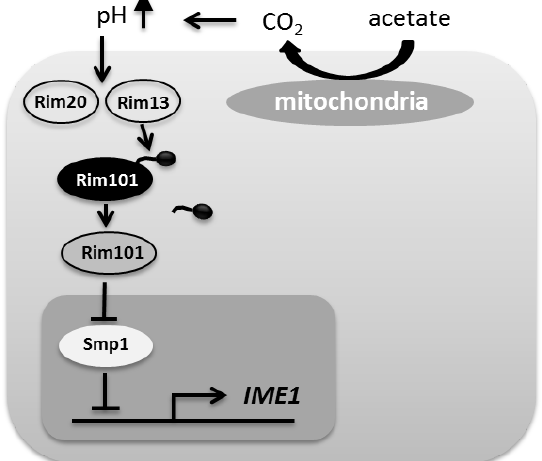
Figure 1. Induction of sporulation in response to alkaline pH in S. cerevisiae . When a non-fermentable carbon source is metabolized by respiration the external pH increases. The alkaline pH induces proteolytic activation of Rim101 by Rim13/Rim20. Rim101 then activates IME1 transcription by repressing transcription of the repressor Smp1 [14].